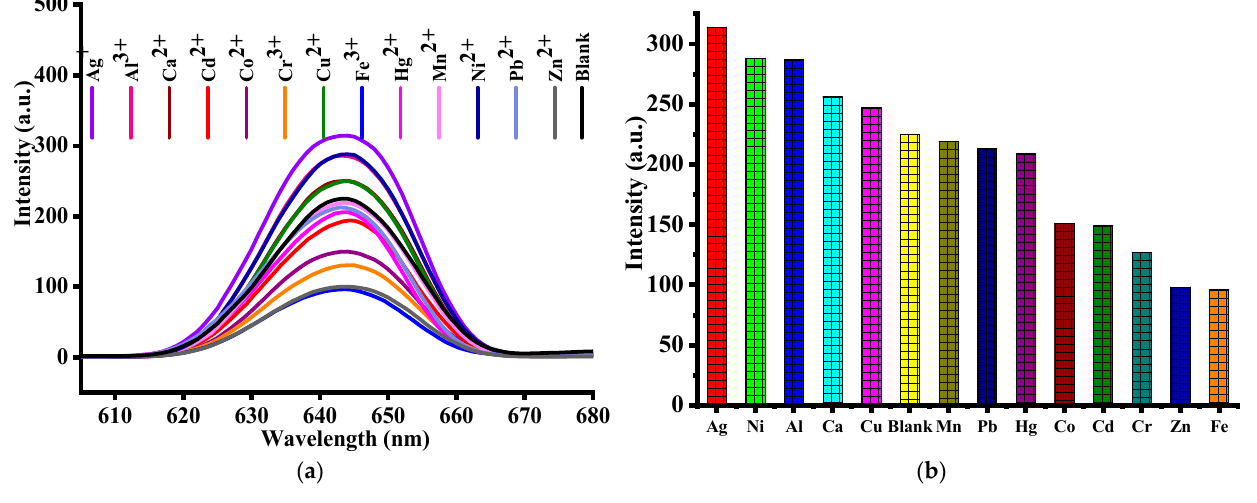
Figure 9. ( a ) Photoluminescence spectra of 1 in water and aqueous solutions containing different metal ions (1 ×10 − 3 M) when excited at 358 nm; ( b ) The photoluminescence intensities of 1 in aqueous solutions with various inorganic cations (1 × 10 − 3 M) when excited at 358 nm.